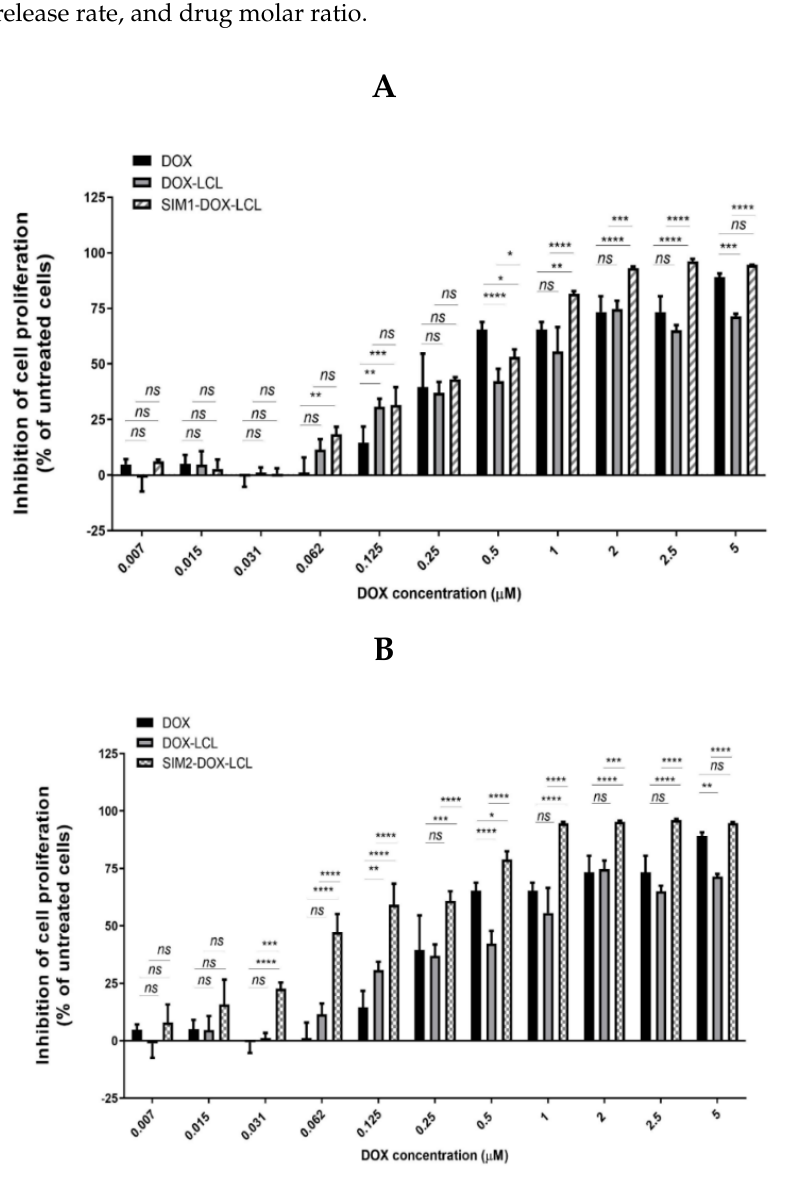
Figure 11. (A , C , E ) represent the size distribution of DOX-LCL, SIM1-DOX-LCL, and SIM2-DOX-LCL, respectively. ( B , D ,( F ) represent the zeta potential distribution of DOX-LCL, SIM1-DOX-LCL, and SIM2-DOX-LCL, respectively. The measurements were performed in triplicate, and each measurement is represented with a different colour (blue, red, or green).